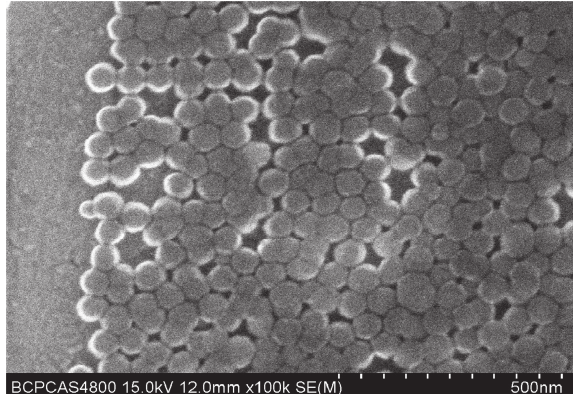
Figure 7: SEM image of the